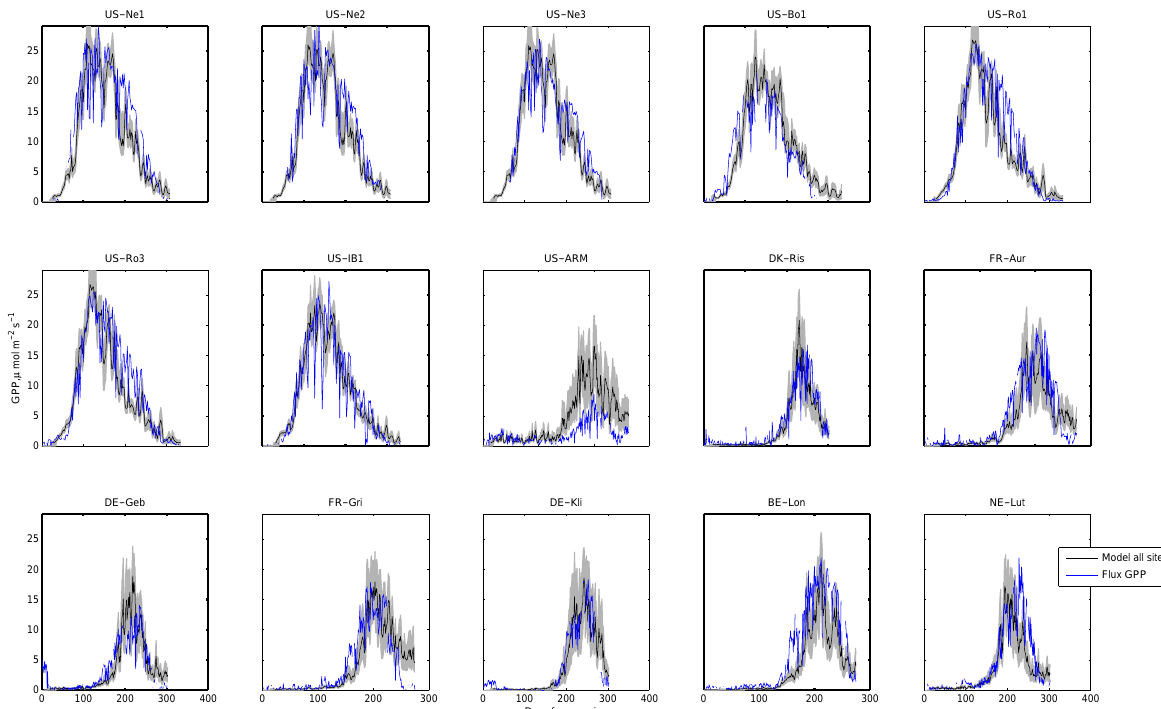
Figure A4. Gross primary production predictions for 1 year for all sites fitted using all available data at a subset of sites for model evaluation. Sites with black boxes have been used in the model fitting. Grey shaded areas represent 95% confidence intervals drawn from the posterior